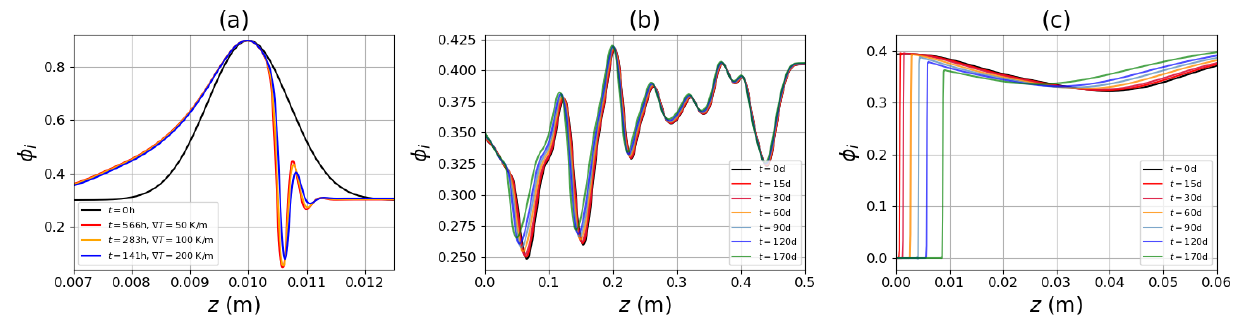
Figure 7. Simulation of the fully coupled system: (a) time-temperature scaling. (b) Evolution of a smooth initial ice profile and fixed mean temperature gradient of 50Km − 1 . (c) Same as (b) but with homogeneous Neumann BC and impact on depletion of mass at the